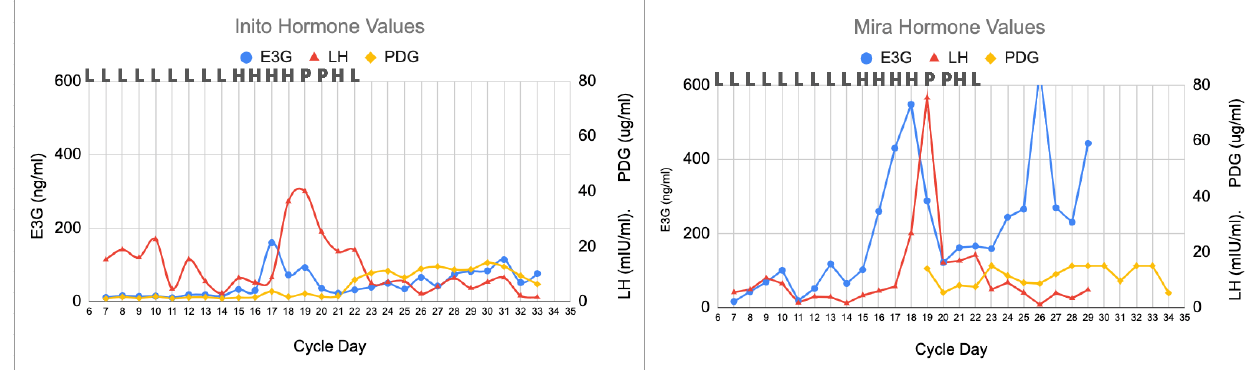
Figure 2. Longer cycle with prolonged luteinization process. All three monitors agreed on the peak day, with the highest LH value on that day (cycle day 19). The ClearBlue results (L = Low, H = High, and P = Peak) are shown above each graph on the respective days. The estimated day of ovulation was day 20 (day after the LH peak). The luteal phase was 14 days (cycle length of 34 days). With both the Inito and Mira monitors, there were two PDG dips on day 25.